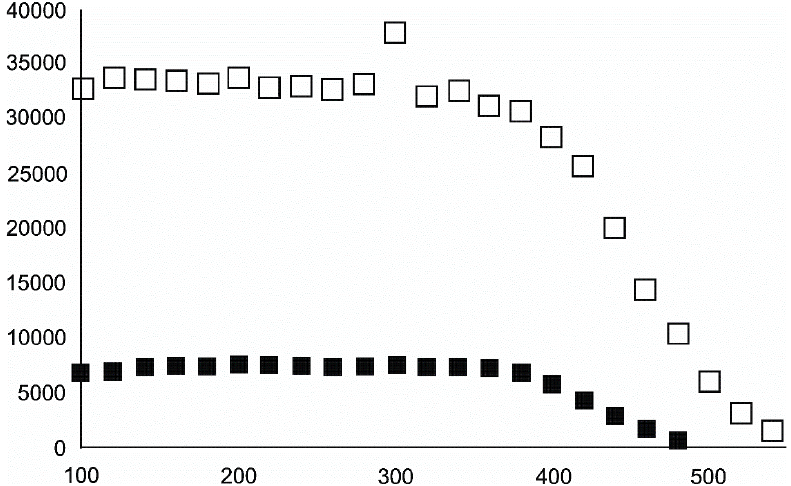
Figure 9. Relation of the number of counts (intensity) derived from the main reflection (hkl = 104) of siderite to temperature (bottom axis, °C). Symbols as in Figure 1.